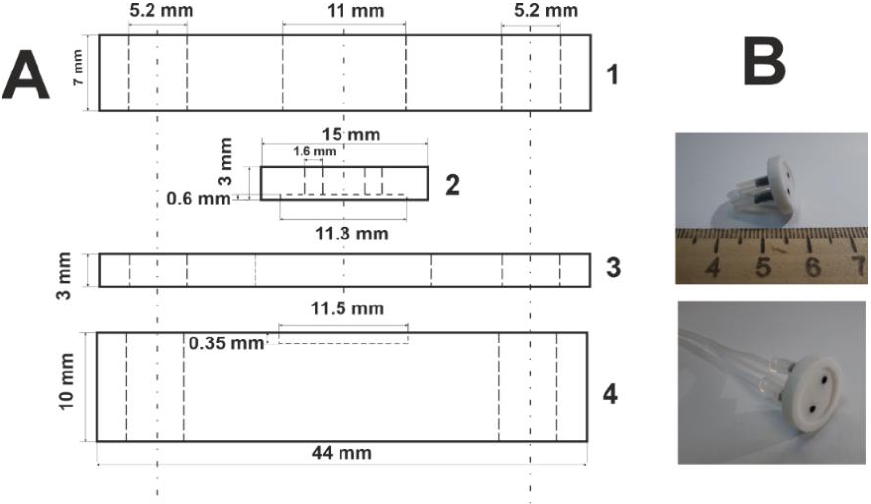
Figure 3. ( A ) Flow-through cell design. 1—holding lid, 2—flow-through reactor, 3—intermediate gasket, 4—base of the cell; ( B ) photographs of the reactor with plastic tubes.